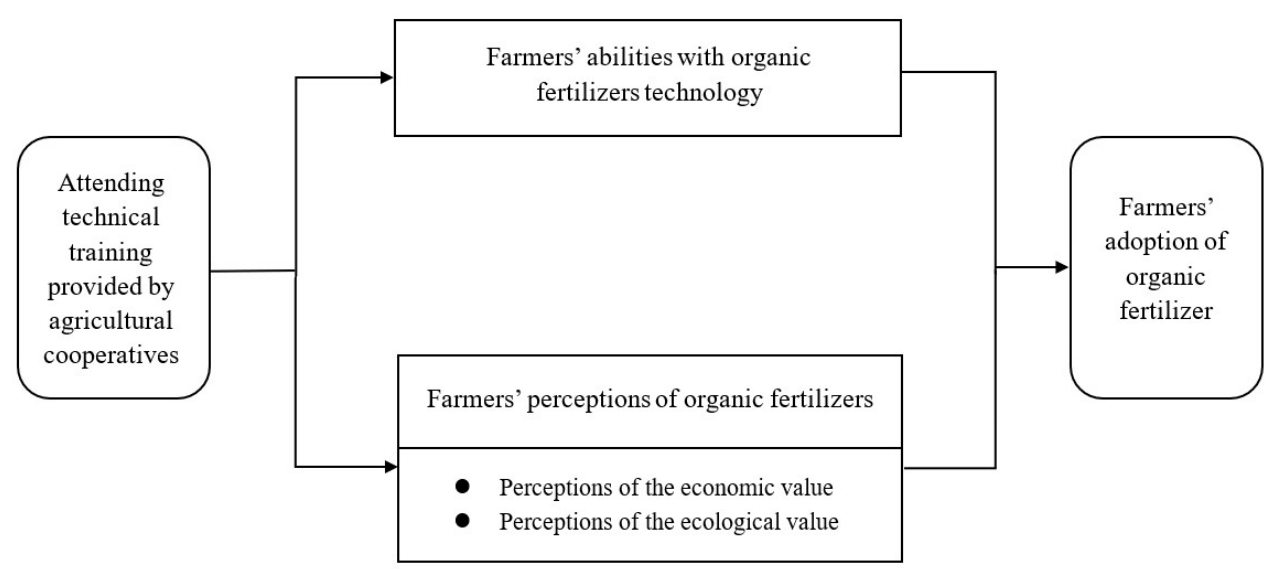
Figure 1. Theoretical